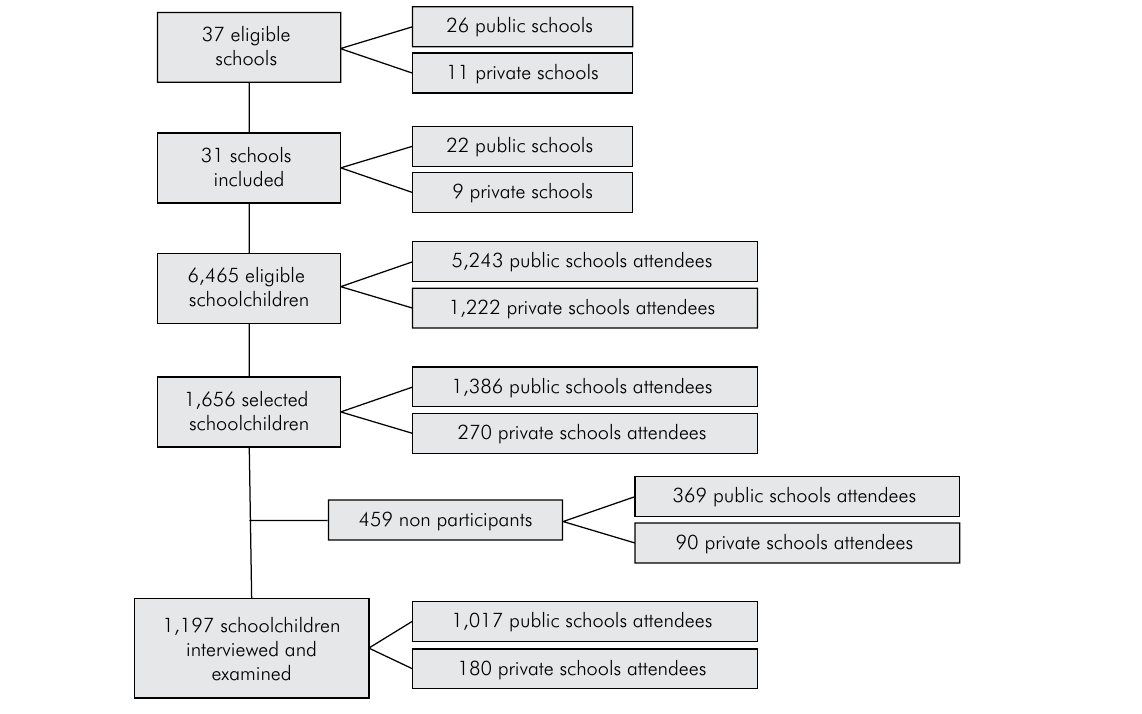
Figure 2. Flowchart of the